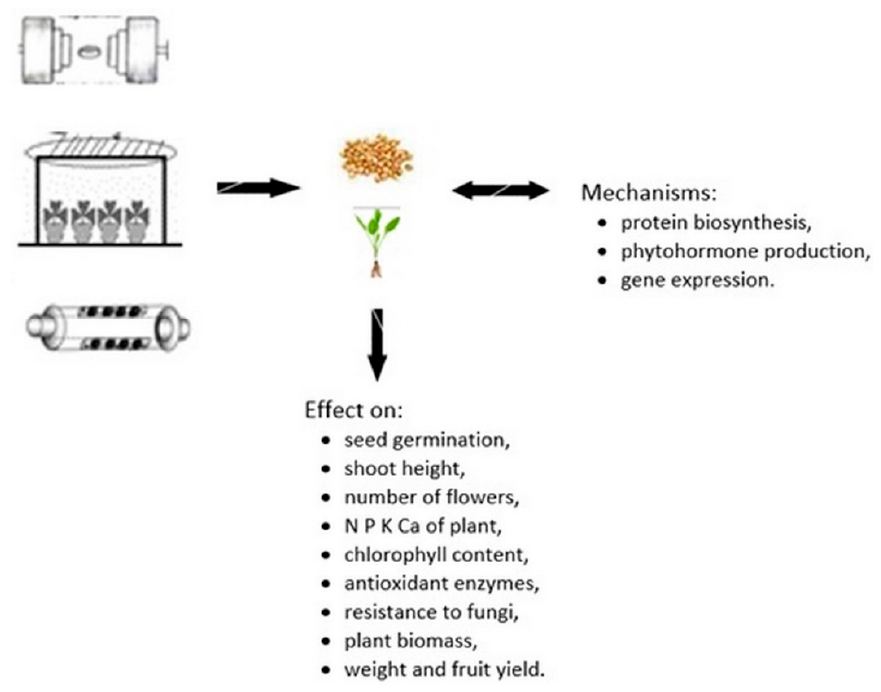
Figure 1. Magnetic field affecting the morphophysiological properties on a fruit plant with possible mechanisms.